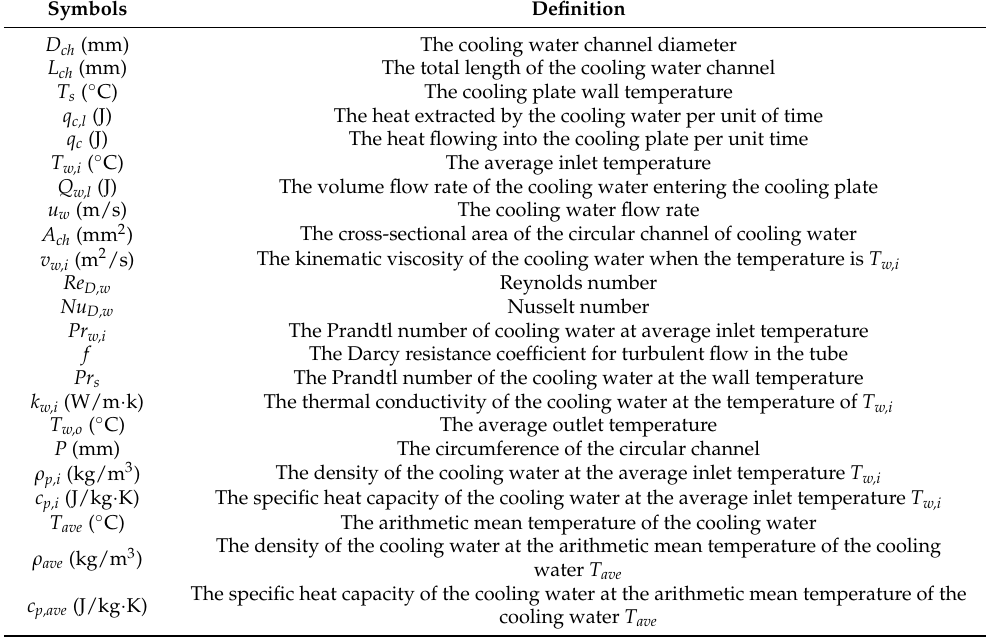
Table 1. Representation of theoretical calculation